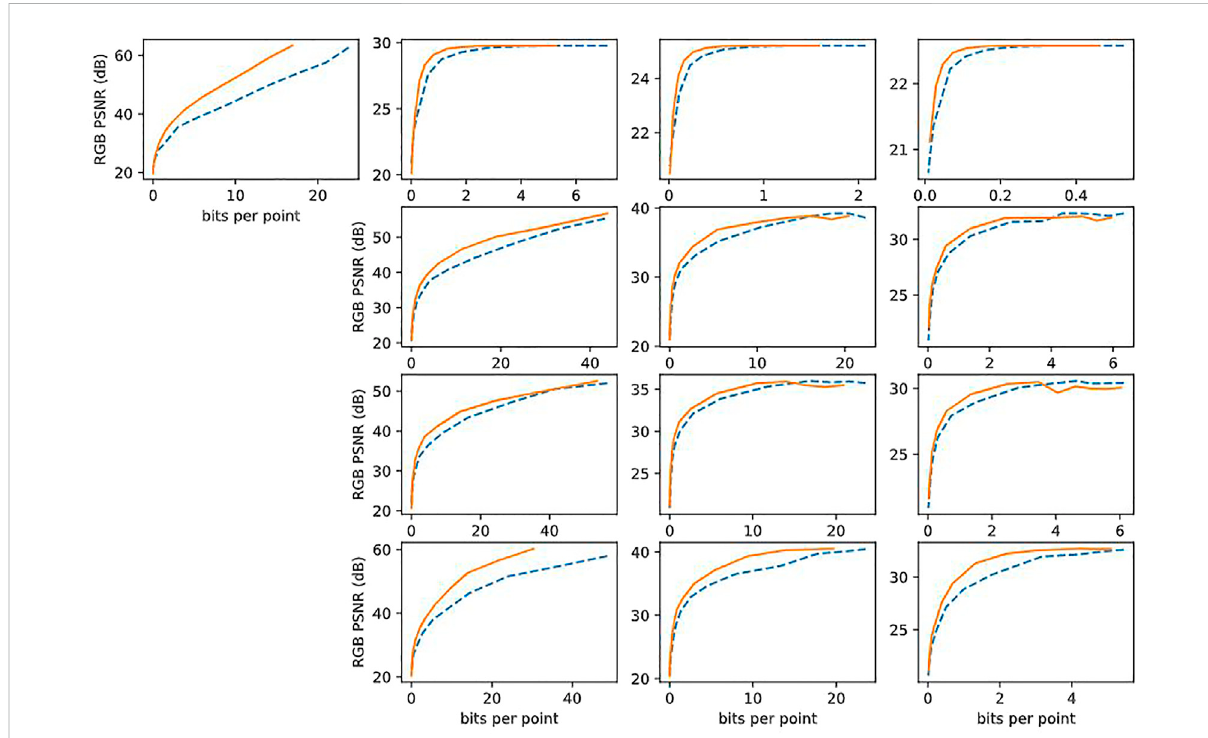
FIGURE 11 RD performance improvement due to normalization, corresponding to entries in Table 1, i.e., columns 1, 2, 3, 4 correspond to levels 30, 27, 24, 21, respectively, and rows 1, 2, 3, 4 correspond to linear(3x3) , mlp(35 × 256 × 3) , mlp(35 × 64 × 3) , pa(3 × 32 × 3) , respectively.